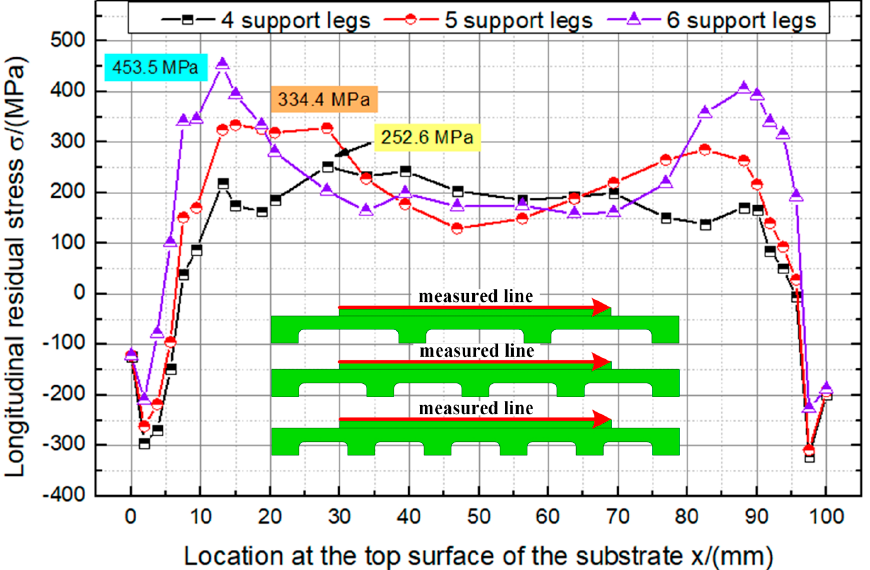
Figure 13. Longitudinal residual stresses on the top surfaces of the deposition layers with different numbers of support legs.